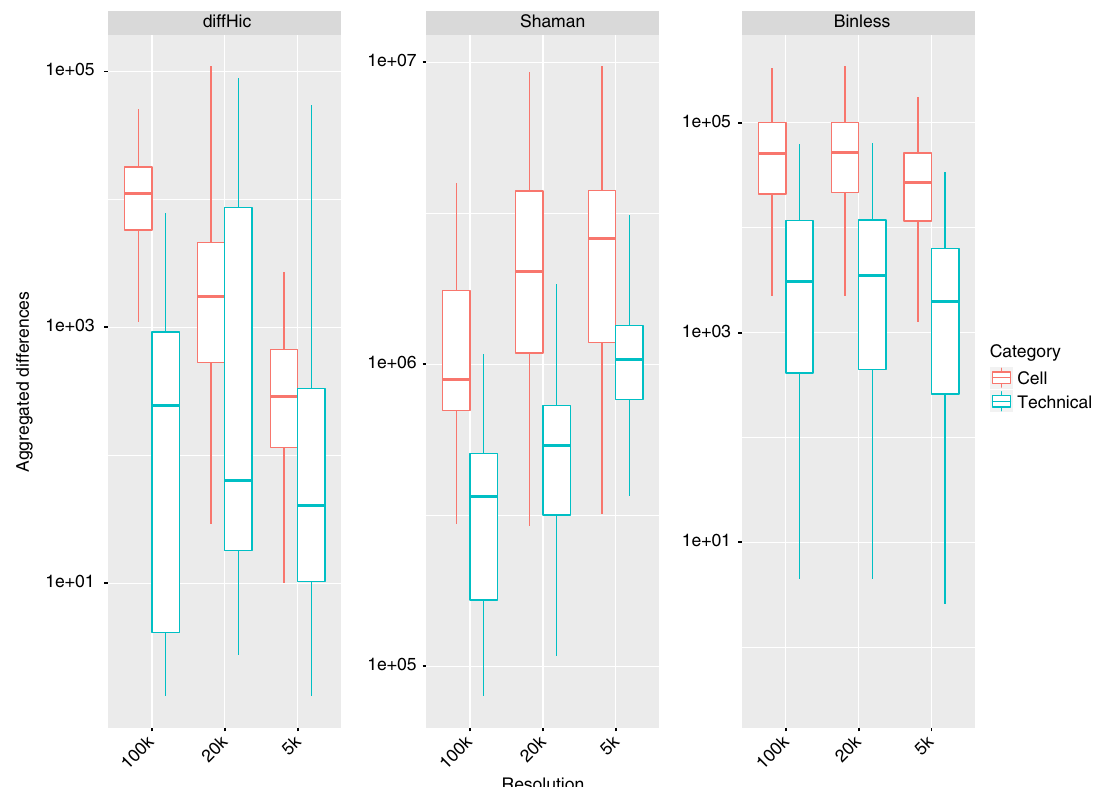
Fig. 4 Binless differences are more numerous between cells than between technical replicates. See methods for details and Sup. Table panel 10 for total number of difference